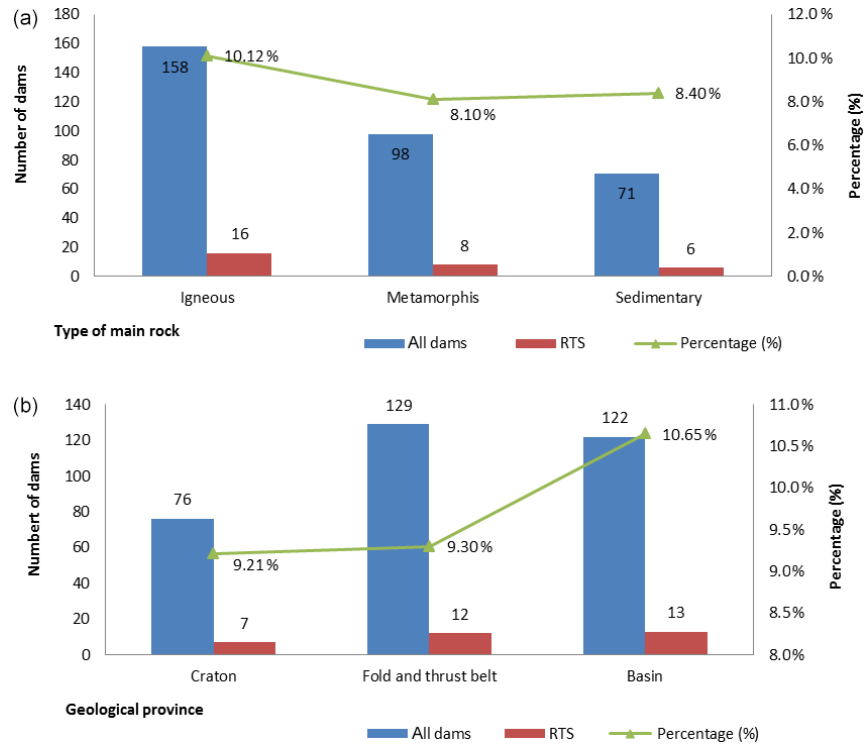
Figure 9. (a) Percentage of cases of reservoir-triggered seismicity in Brazil as stated by main rock types (sedimentary, metamorphic, and igneous) in the dam area. (b) Classification as stated by the main geological